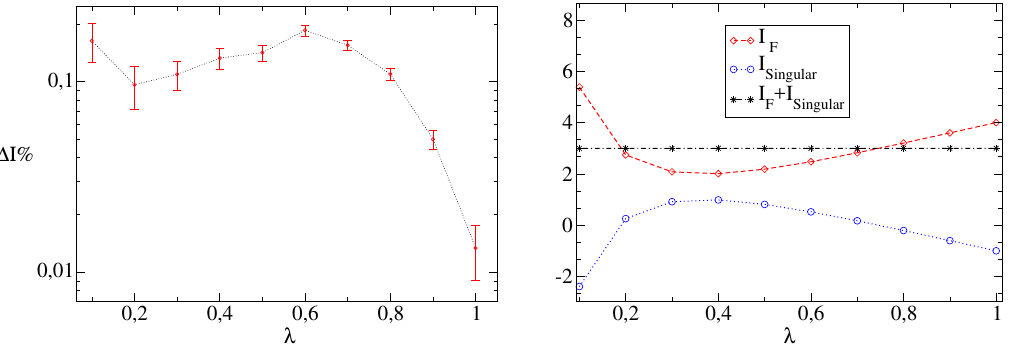
Figure 4 . This (cid:12)gure shows (cid:1) I ( (cid:21) ) on the left and also separately the (cid:15) 0 coe(cid:14)cients of I F ; I Singular and their sum on the right in the subtraction method. In both (cid:12)gures I F is evaluated numerically with the CUBA implementation of the Vegas algorithm using 10 8 points for each value of (cid:21)